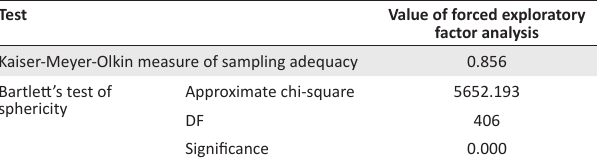
TABLE 2: Kaiser-Meyer-Olkin and Bartlett’s test of sphericity.